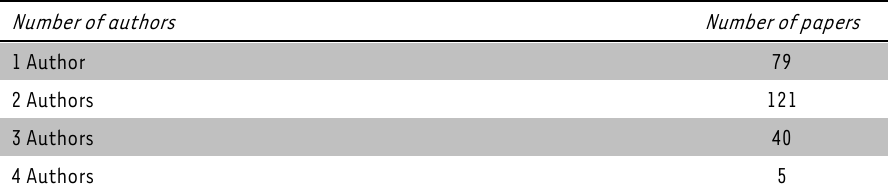
TABLE 3: Number of authors per paper